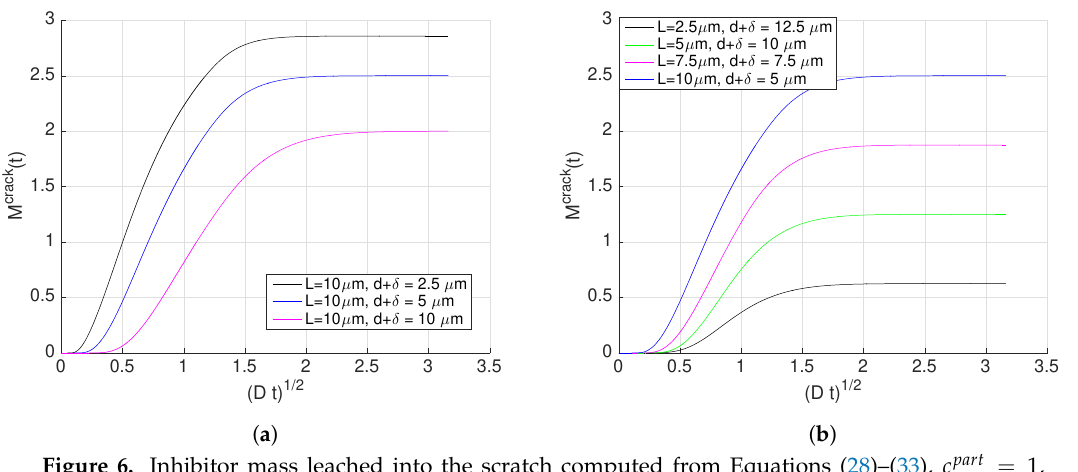
Figure 6. Inhibitor mass leached into the scratch computed from Equations (28)–(33), c part = 1, c sol = 0.7, c 0 = 0, D = 5. ( a ) The particle size L is kept constant, and its distance to the scratch d + δ is varied. ( b ) The total distance L + d + δ is kept constant but the size of the particle L is